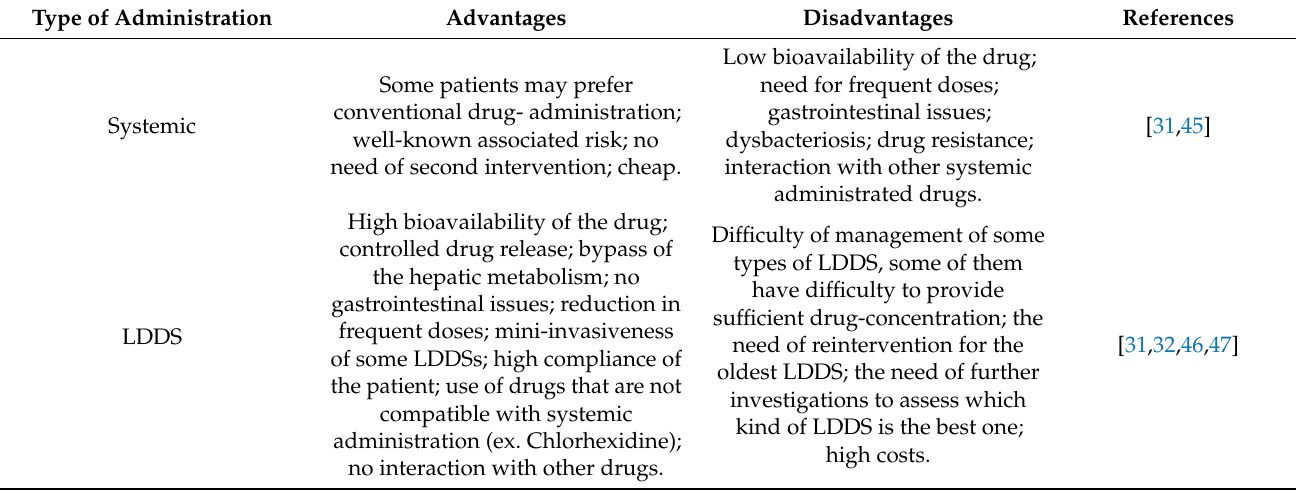
Table 2. Advantages and disadvantages of systemic and LDDS administrations. Type of Administration Advantages